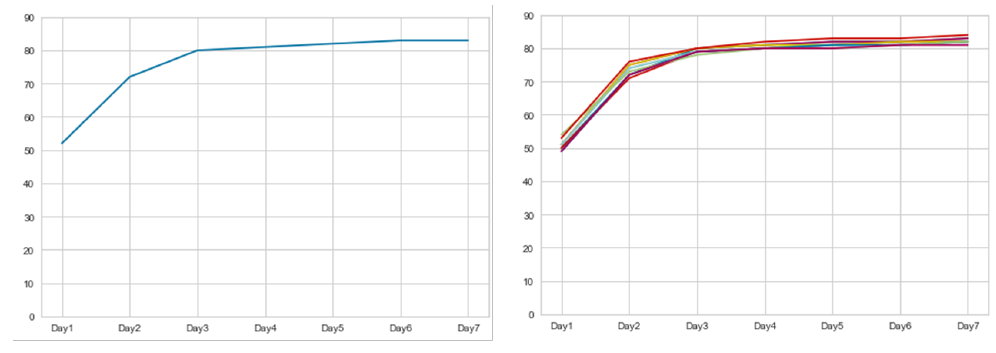
Figure 5. Results of Table 3.